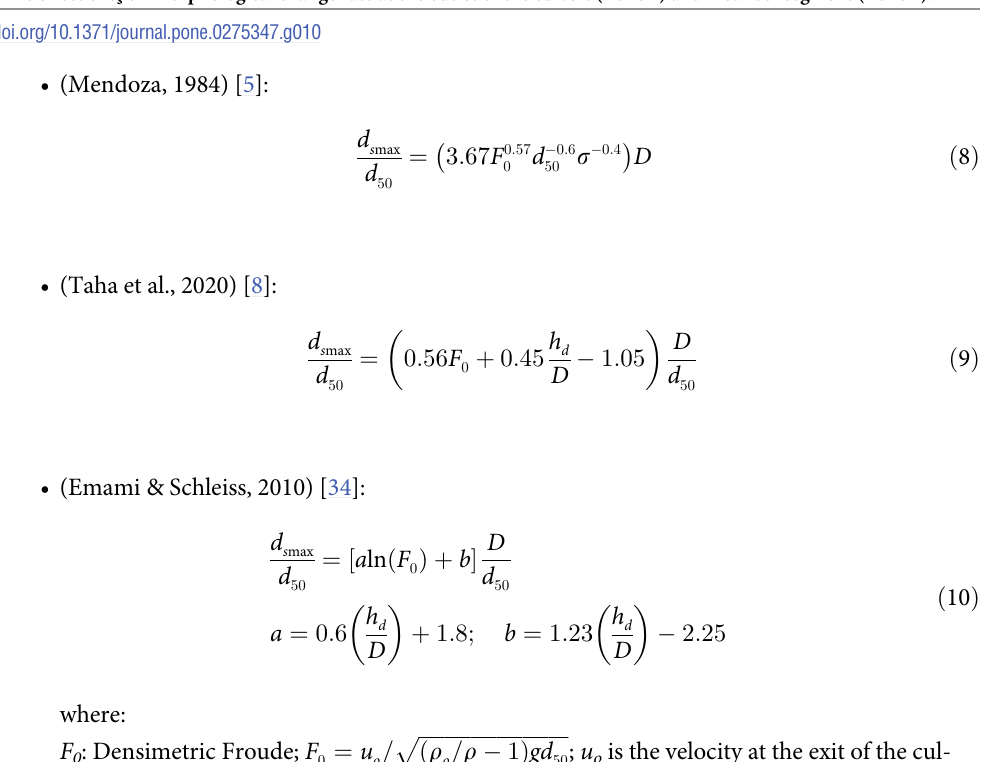
Table 4. Relation of c